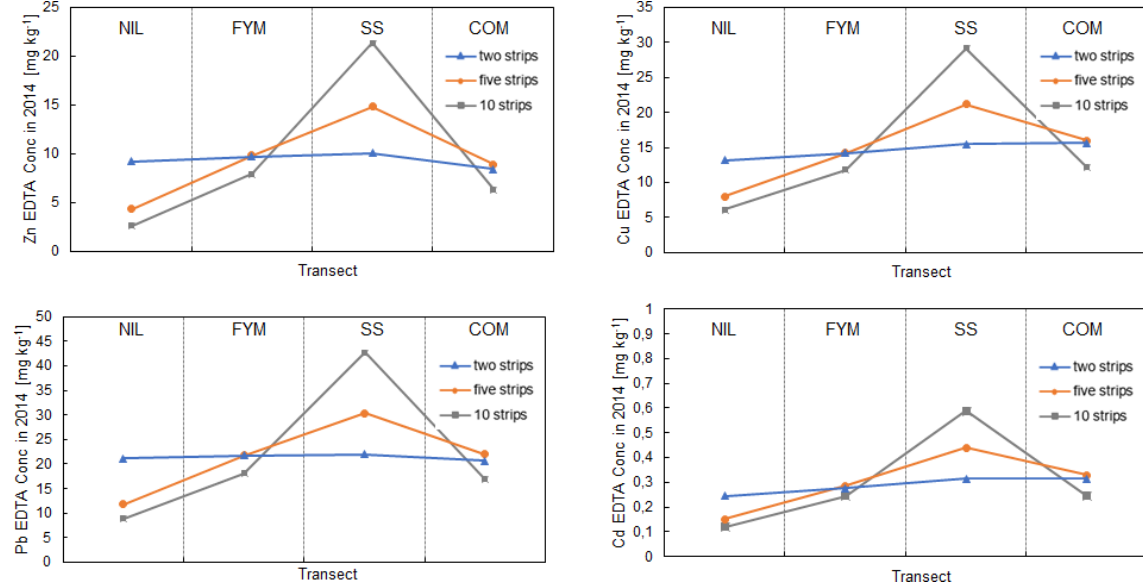
Figure 6. Simulated labile concentrations of Zn, Cu, Pb and Cd in 2014 across a transect comprising the plots NIL, FYM, SS and COM in series with five and 10 strips per plot with idealised trend inputs.